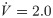
Performance of the motif 2 feedback scheme with zero-order based integral control and a cell-internal compensatory flux.Rate constants and initial conditions: k3 = 2.0, k4 = 1 × 10−3, k6 = 1 × 105, k7 = 1 × 10−6, k8 = 1.0, k9 = 2.0, k10 = k11 = 1 × 10−6, A0 = 2.0, E0 = V0 = 25.0, M0 = 1 × 106, N0 = 3 × 106. Phase 1: V and k3 remain unchanged. Phase 2: V increases linearly with V˙=2.0, while k3 remains constant. Phase 3: V continues to increase and k3 increases linearly with k3˙=1.0.